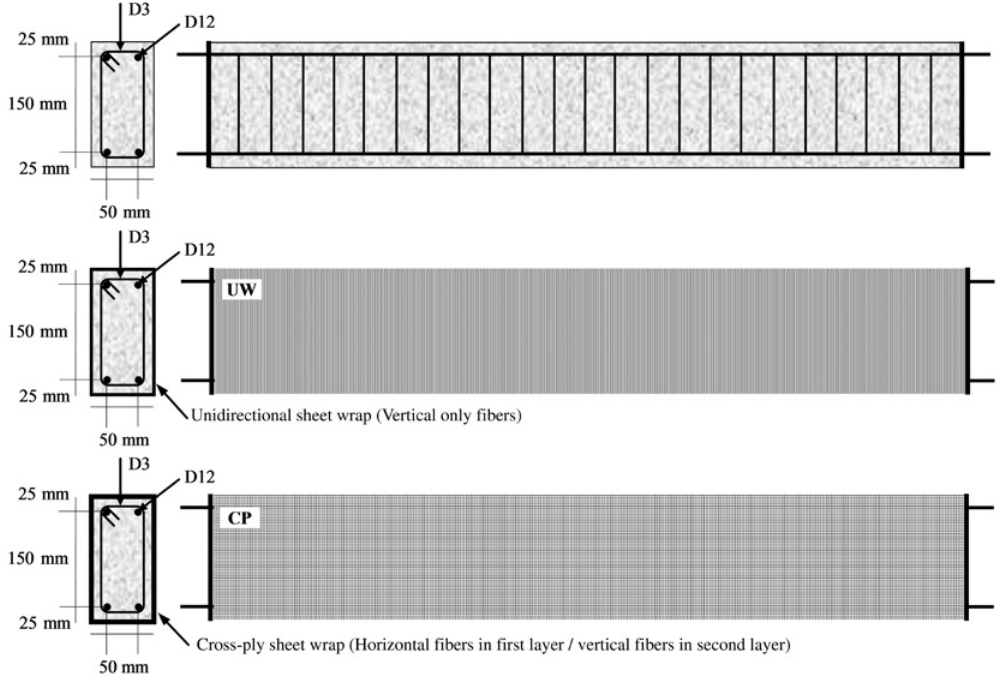
Figure 2: Reinforcement and CFRP wrapping scheme configuration of